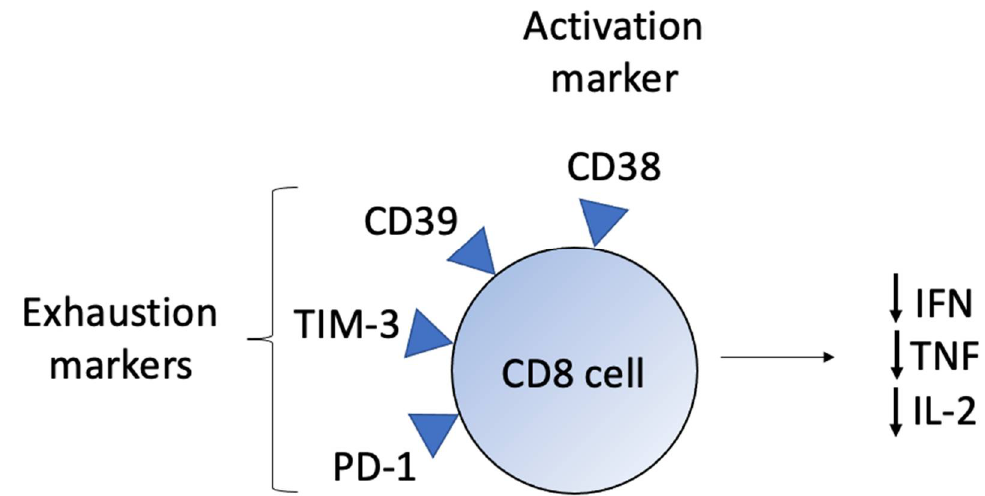
Figure 2. CD8+ T-cell characteristics in SS. Activation of CD8+ T-cells is detected by the expression of CD38, and the chronic activation leads to an exhaustion phenotype with the expression of CD39, TIM-3, and PD-1. Furthermore, in exhausted CD8+ T-cells, a functional loss is observed, with re-